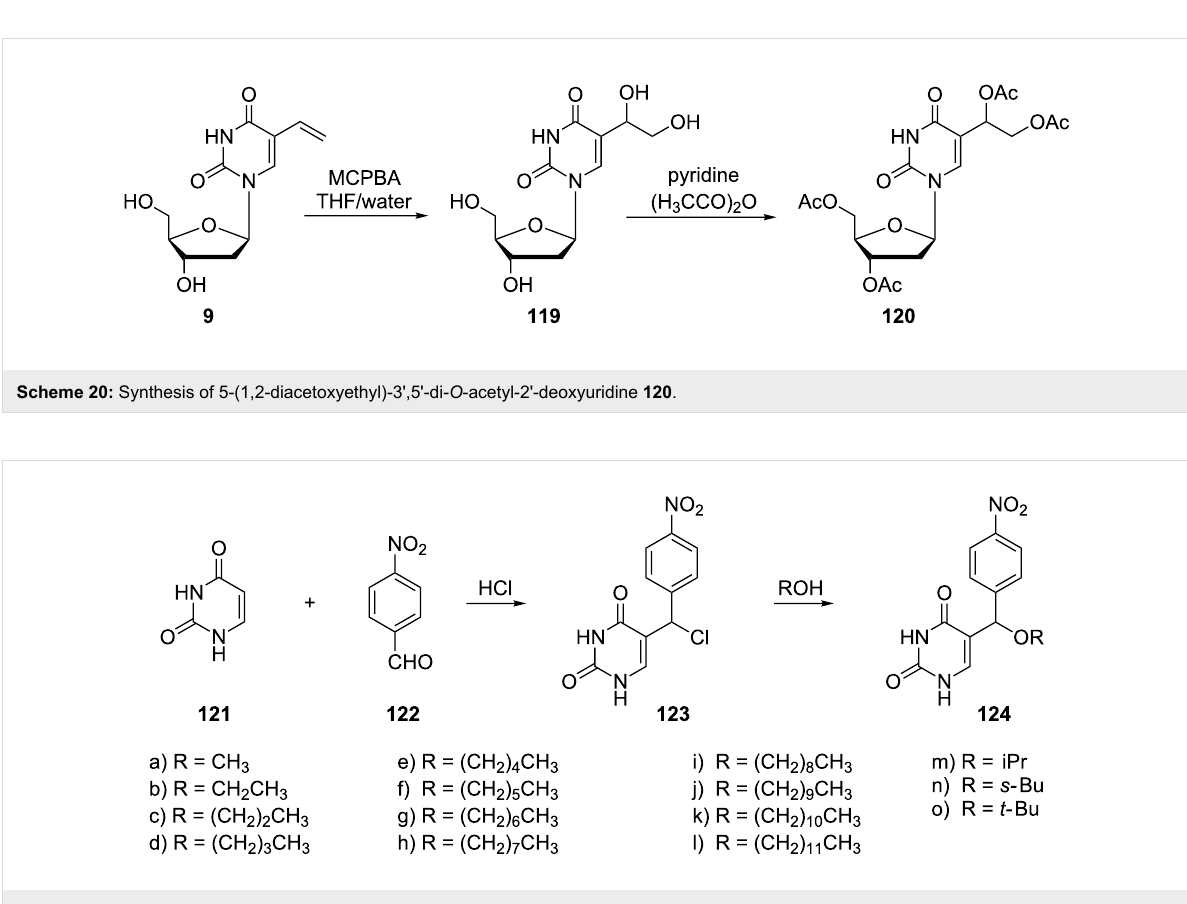
Scheme 19: Synthesis of 5-(1-acyloxyethyl)-1-(tetrahydrofuran-2-yl)uracils 117 and 118 .